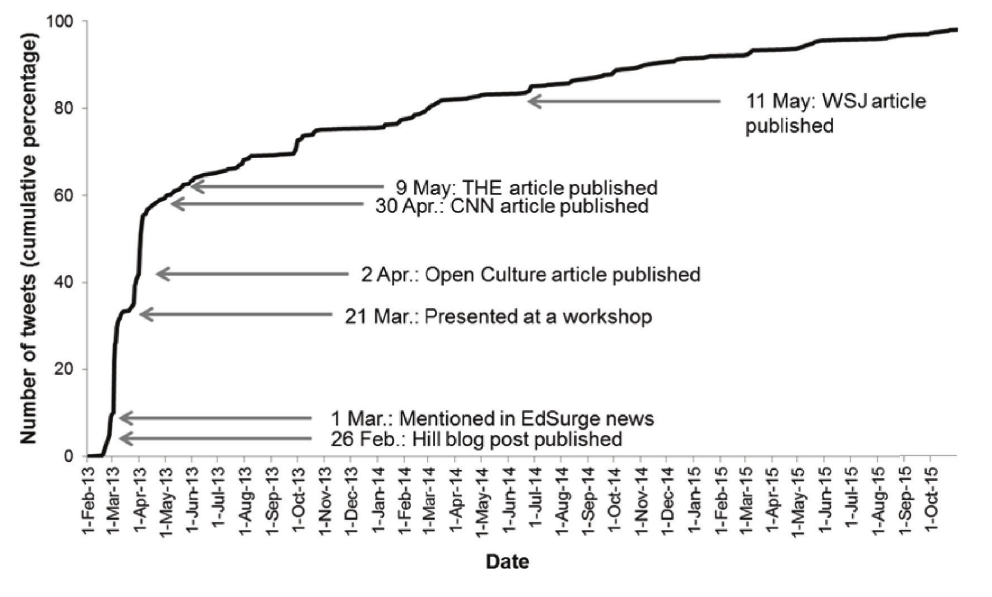
Figure 2: Number of tweets over time that mention the visualization link, as a cumulative